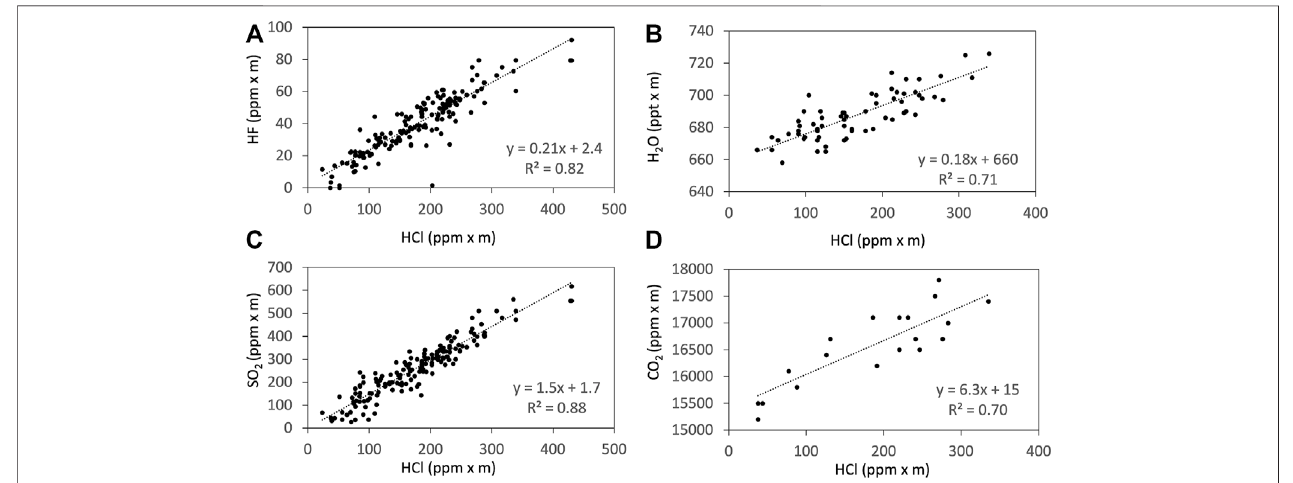
FIGURE 6| Examplesof the correlationsfrom the Ratiocalc analyses (Tamburello, 2015) of HCl to HF (A) , H 2 O (B) , SO 2 (C) , and CO 2 (D) measured using FTIR on 15 January 2018. The H 2 O column amount is shown in ppt x m to avoid rounding errors during the Ratiocalc analyses.